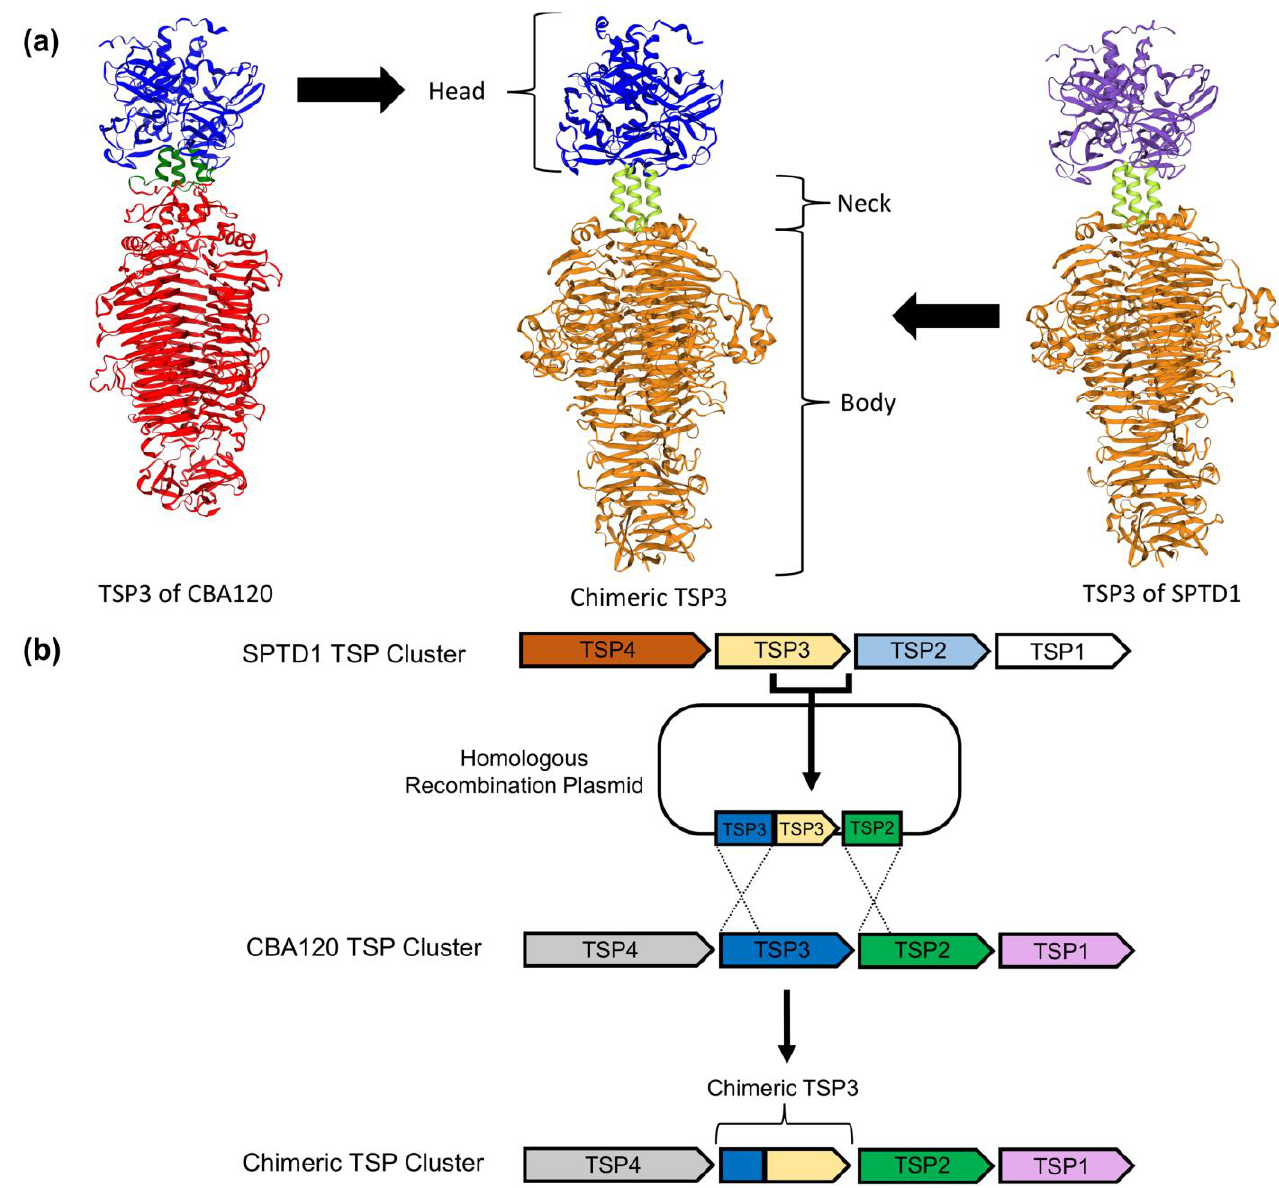
Figure 2. Ackermannviridae tailspike proteins can be engineered to generate chimeric receptor-binding proteins. Computational predictions ( a ) of the trimeric structure of TSP3 for CBA120, SPTD1, and the proposed chimeric TSP3 were generated using Alphafold2 and visualized with the SWISS-MODEL Workspace [44–46]. The predicted structure of CBA120’s TSP3 is highly similar to a previously reported crystal structure [39]. Color was used to visually distinguish regions and source for the proposed TSP3 chimera. Homologous recombination ( b ) was used to generate a chimeric TSP3 by replacing the C-terminus of CBA120’s TSP3 with the analogous region in SPTD1. Each TSP in the SPTD1 and CBA120 cluster was assigned a color at random to allow tracking throughout the engineering